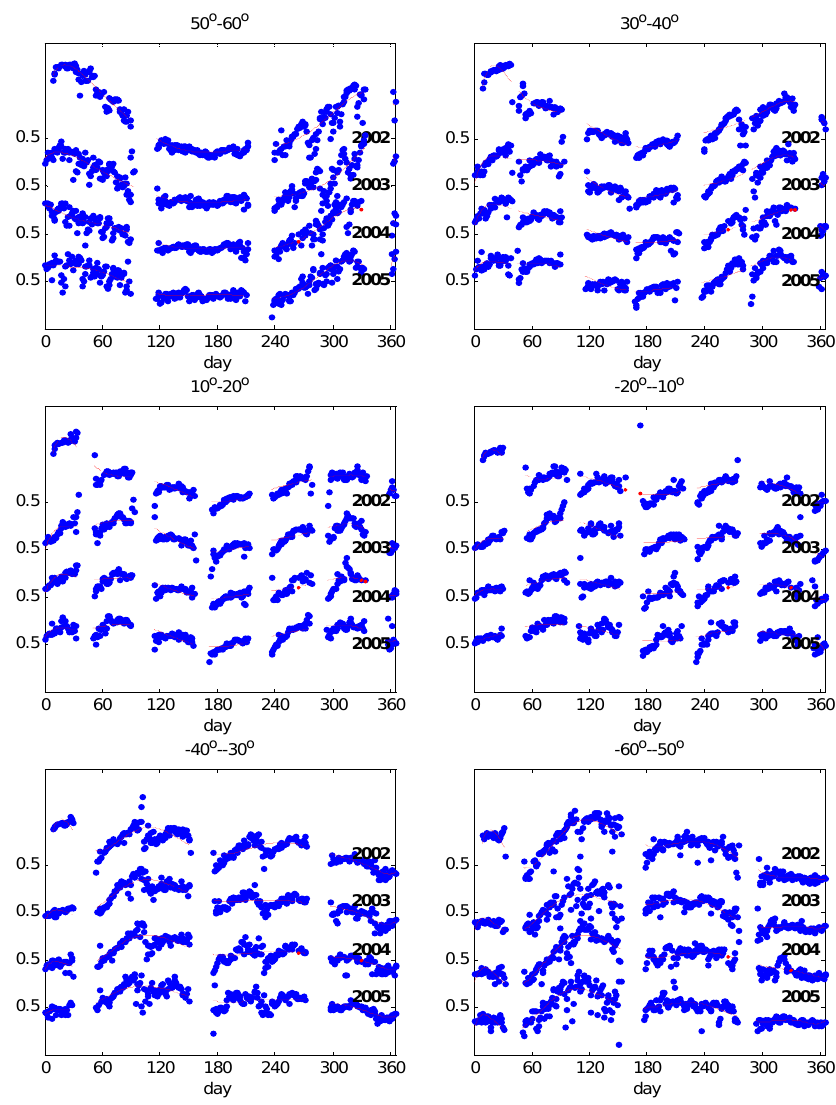
Figure 9. Yearly variation of GUVI measured average [O/N2] for each Fig. 9. Yearly variation of the GUVI measured average [O/N2] for each latitude zone during 10:00–14:00 MLT. The red line denotes the latitude zone during 10:00-14:00 MLT. The red line denotes the smooth smooth value fitted according to Eq. value fitted according to equation (2).